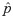
Optimal control of the self-replicator during a nutrient upshift.A: Optimal trajectory in the phase plane for the nondimensionalized model of Eqs 11 and 12, with streamlines. The optimal trajectory is shown as a solid, red curve. The solid, black curve represents the p^-nullcline. The dashed, black curve is the switching curve φ(p^). The optimal solution was obtained by numerical optimization using bocop [41] (see Methods for details), using the parameter values EM = 1 and K = 0.003, and starting from the initial state (0.024, 0.18) at t = 0 (optimal steady state for EM = 0.2). B: Time evolution of the control variable αopt(⋅) (thick, red line) and the environment EM (dashed, black line).